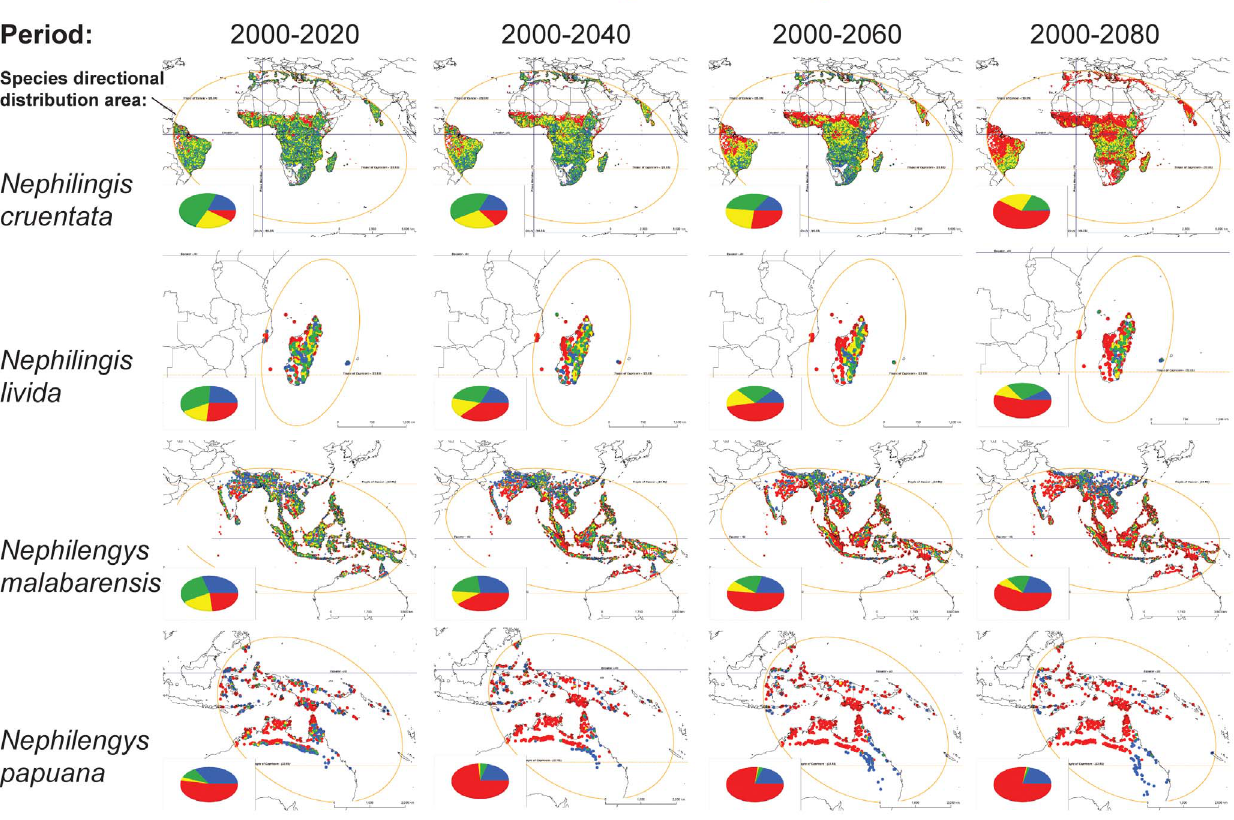
Figure 2. Predicted habitat suitability changes of two Nephilingis and two Nephilengys species over increasing time ranges. The predictions are based on the IPCC scenario A1B for temperature and precipitation (see Figs S1–S2) and are modeled for the time ranges 2000 vs. 2020, 2040, 2060, and 2080. Future habitat is classified as new, unchanged, degraded or lost.